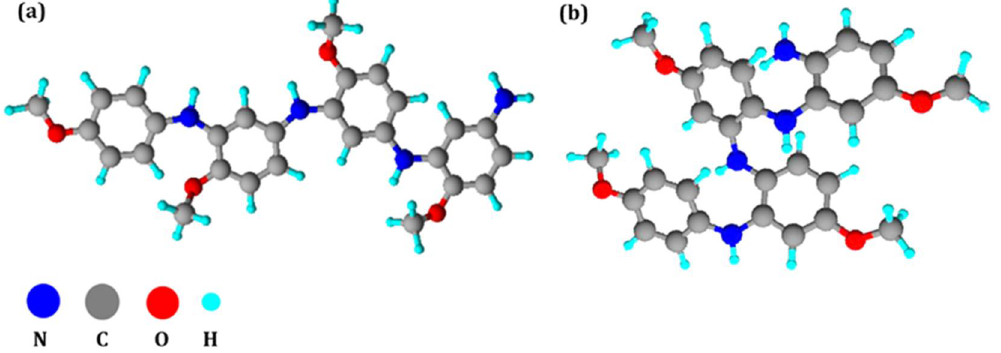
Figure 7. Proposed molecular structures of ( a ) PPA HT and ( b ) PPA HH according to the 13 C NMR results.